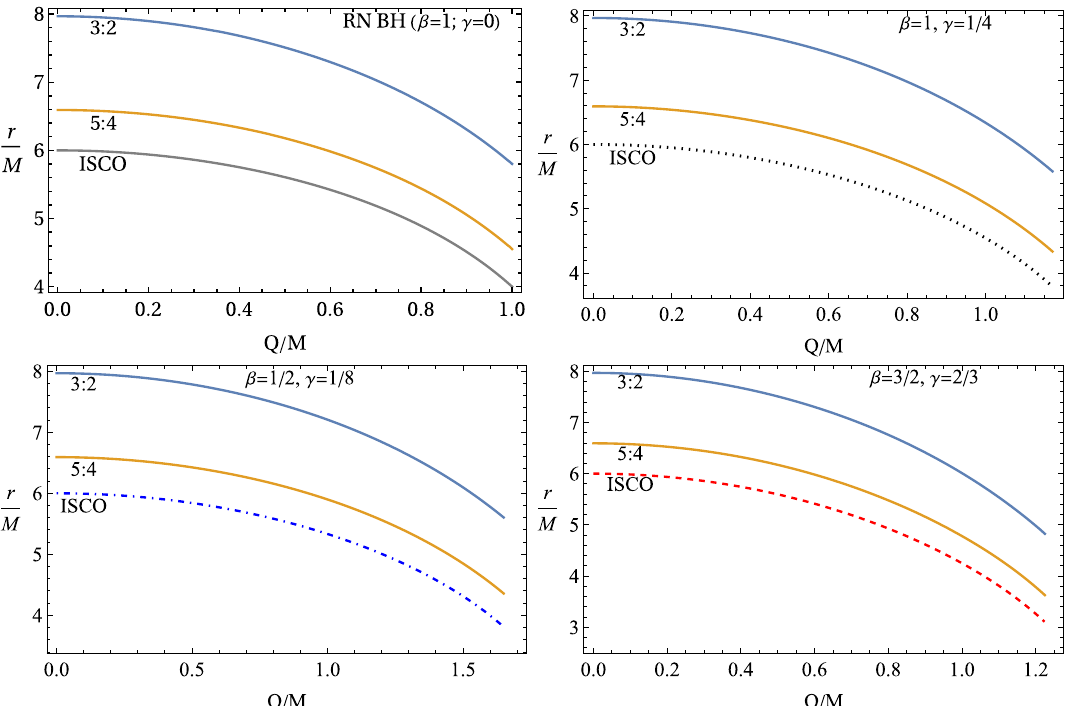
Fig. 13 Radius of QPOs orbits with the frequencies 3:2 and 5:4 and ISCO as a function of the BH charge for various values of γ and β in the frame of the RP